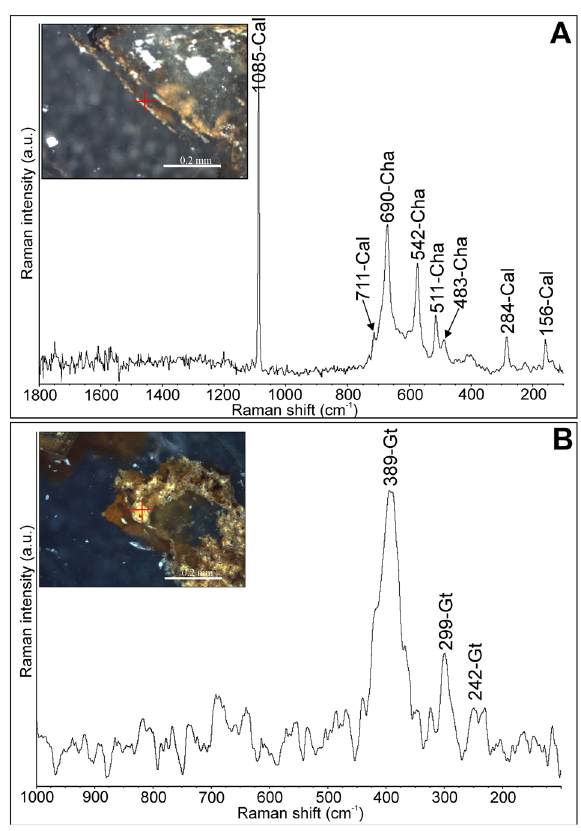
Figure 11. Microphotos of solid inclusions in calcite (Cal) and their Raman spectra: ( A ) chalcophanite (Cha); ( B ) goethite